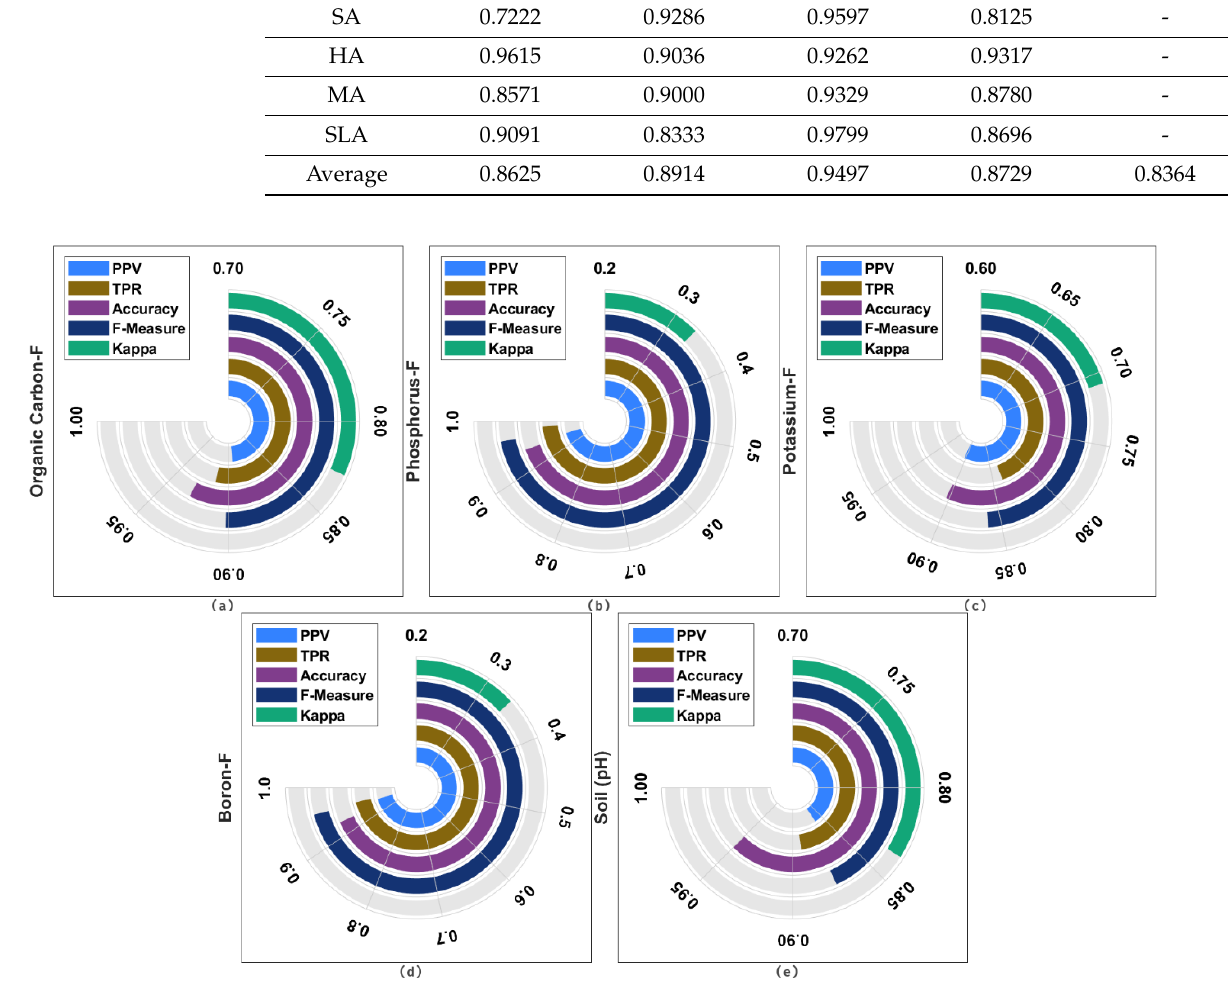
Figure 5. Result analysis of ISNpHC-WVE model.